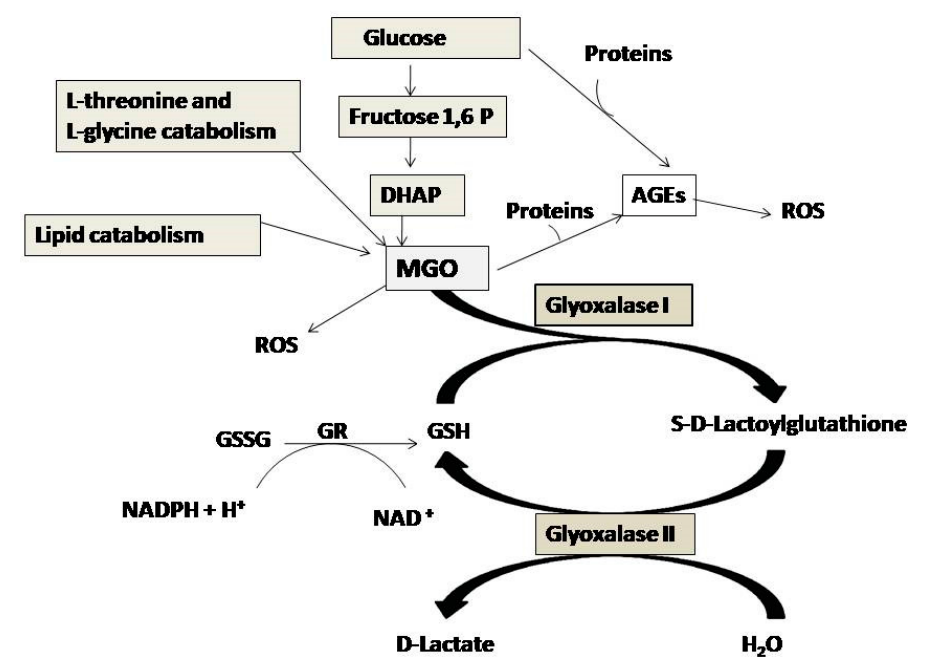
Figure 1. Methylglyoxal (MGO) formation from intermediates of glucose, protein and fat metabolism, and its degradation by the Glyoxalase System. Glyoxalase I (GlxI) converts hemithioacetal formed from glutathione (GSH) and methylglyoxal (MGO) into S-D-Lactoylglutathione (SLG) which is hydrolyzed by Glyoxalase II (GlxII) to D-lactic acid and GSH. Abbreviations: AGEs, advanced glycation end products; DHAP, dihydroxacetone phosphate; ROS, reactive oxygen species; GSH, reduced glutathione; GR, glutathione reductase.